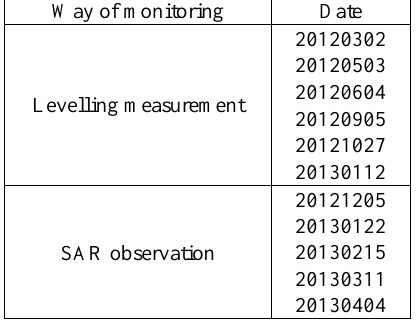
Table 1. The date of levelling and SAR imaging